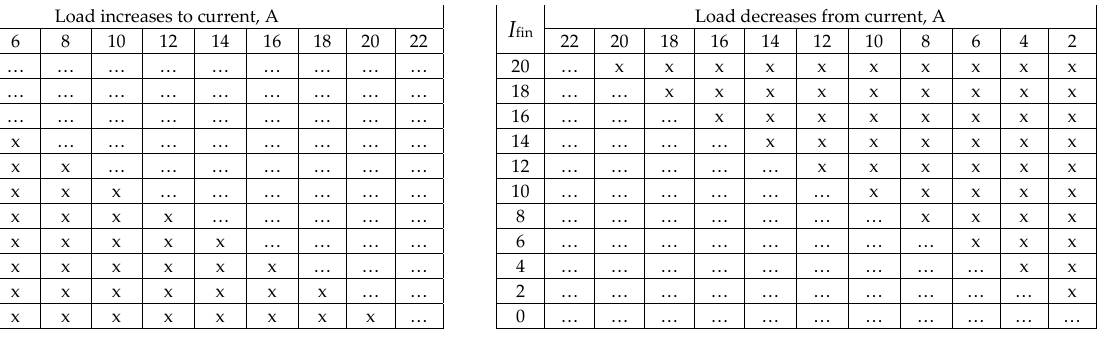
Figure 3. General view of table with measured data: ...—measurement; x—not defined.